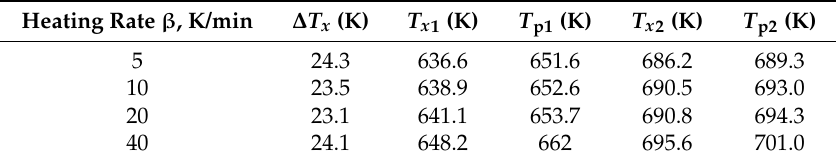
Figure 3. DSC (differential scanning calorimetry) curves of Al 82 La 10 Fe 4 Ni 4 amorphous powder at various heating rates. Table 1. Thermal parameters of the amorphous Al 82 La 10 Fe 4 Ni 4 alloy at different heating rates.